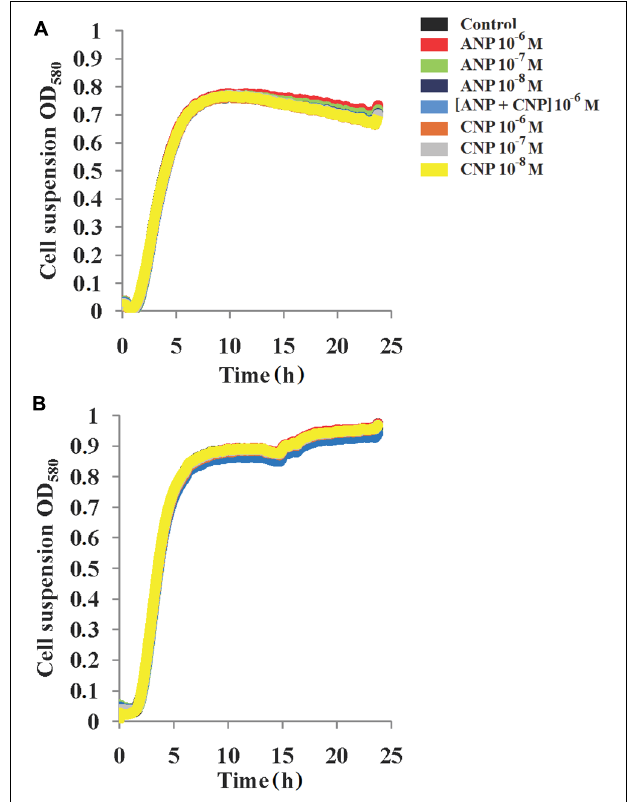
FIGURE 1 | Growth dynamics of S. aureus MFP03 monospecies cultures in the presence of ANP and CNP at different temperatures (A) 37 ◦ C and (B) 33 ◦